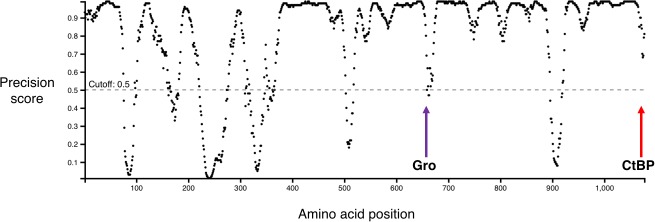
Graph showing predicted disordered regions in Drosophila melanogaster Hairless, generated by DISOPRED3 (Buchan et al., 2013; Jones and Cozzetto, 2015).Locations of the Gro-binding motif (purple arrow) and CtBP-binding motif (red arrow) are indicated. Note that most of the region between these two motifs is strongly predicted to be disordered.